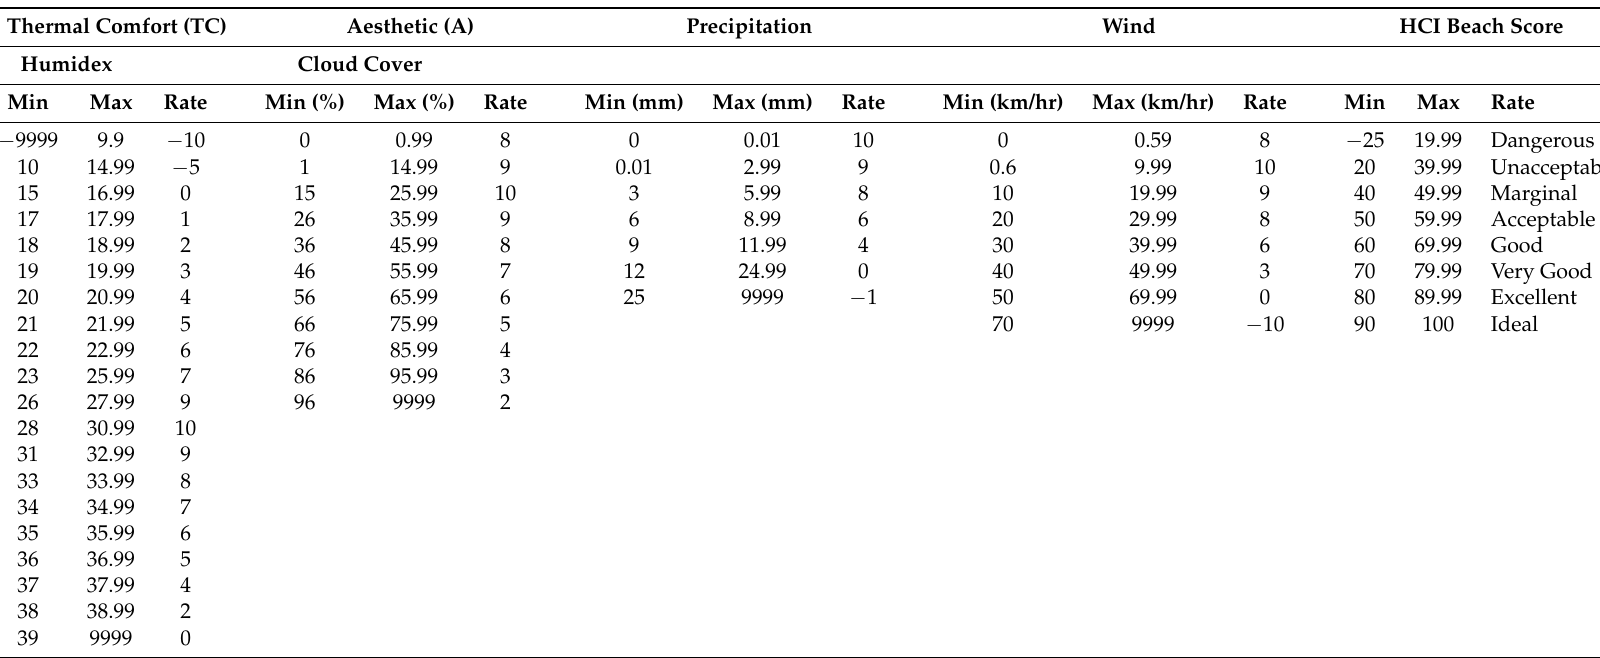
Table 1. The ratings of thermal comfort (according to Humidex), aesthetic (according to cloud cover ), precipitation, wind facets and HCI:Beach